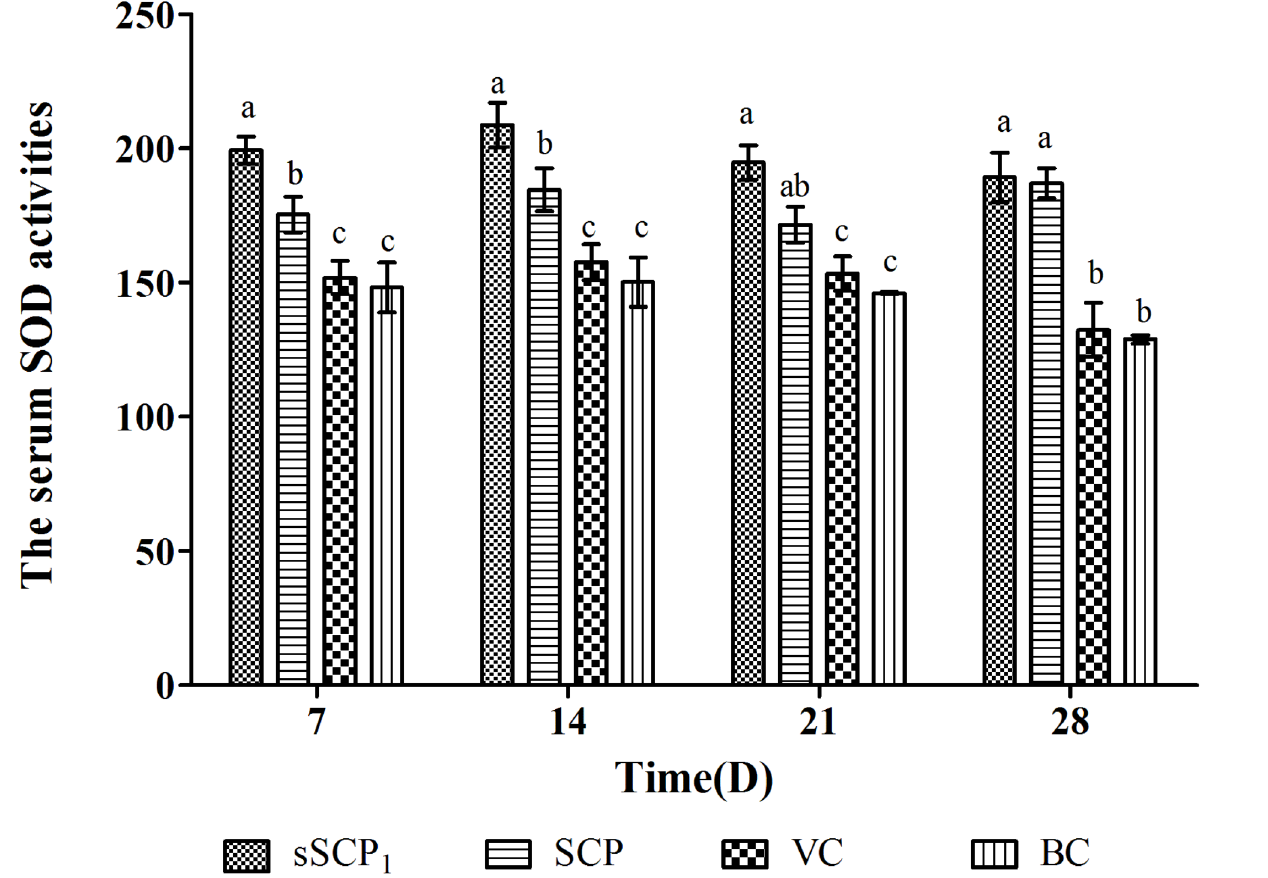
Fig 9. The serum SOD activities in each group. Bars in same time without the same superscripts (a – c) differ significantly ( P < 0.05).